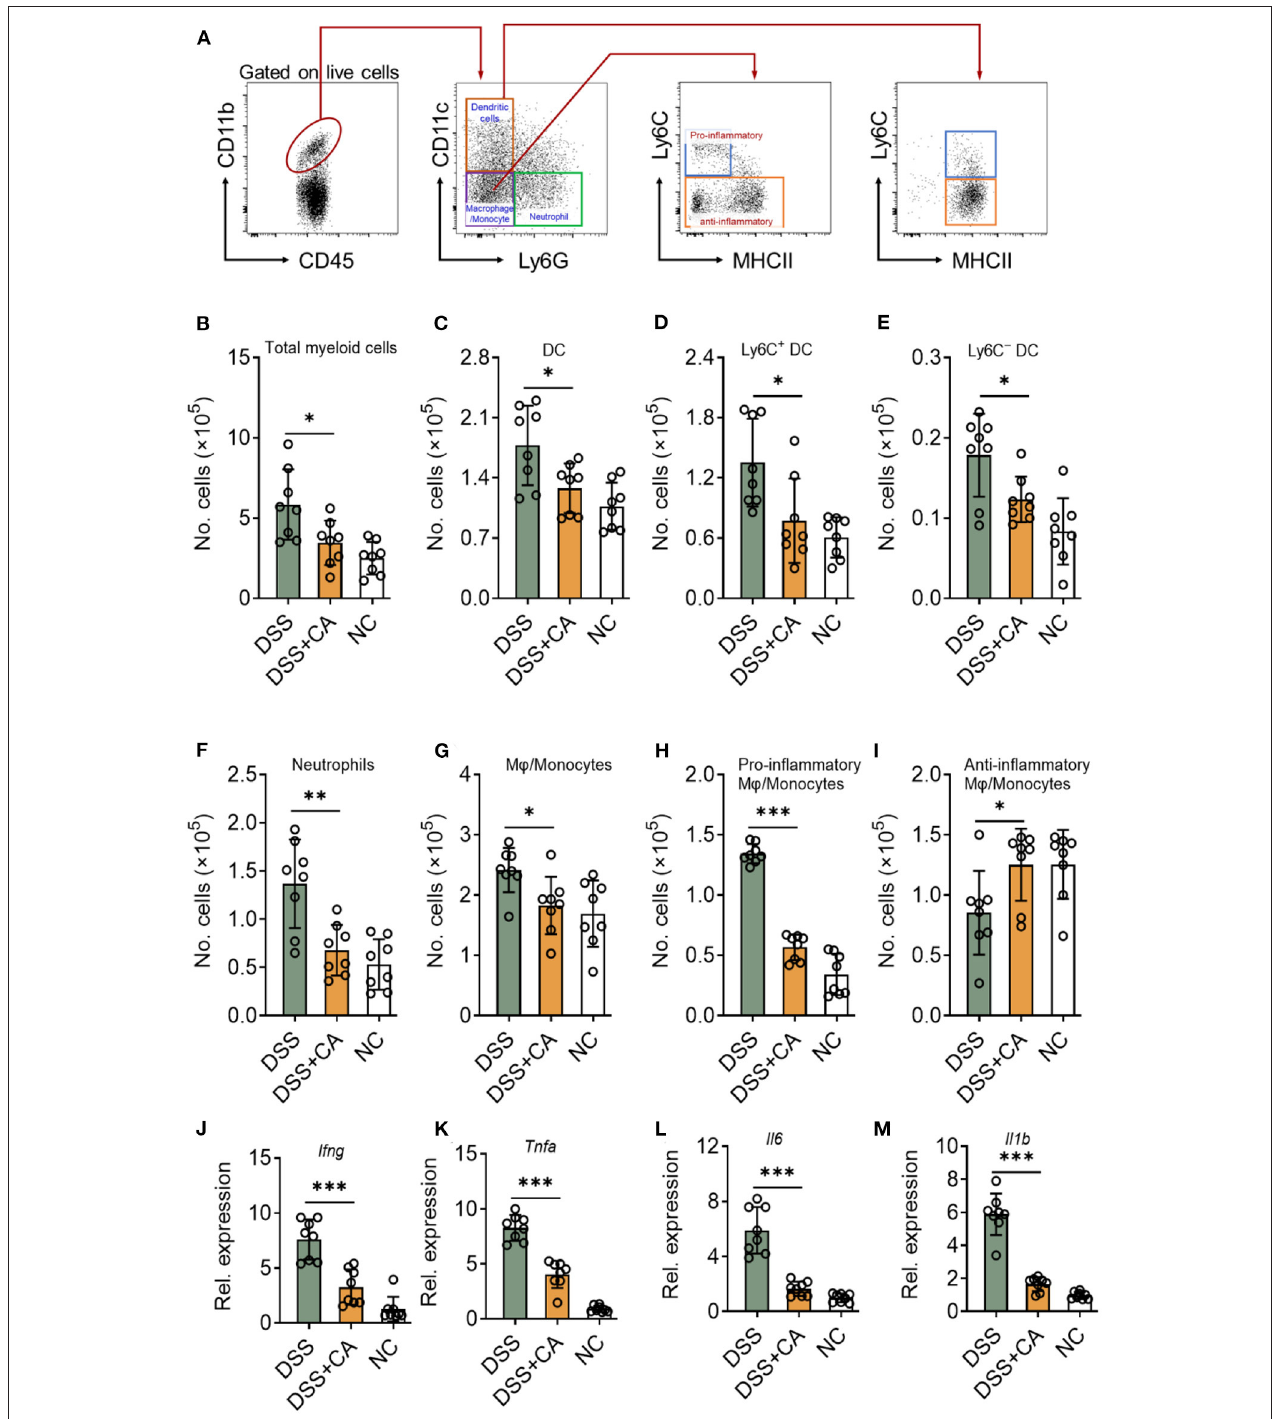
FIGURE 3 | CA suppresses colonic inflammatory responses in DSS-treated mice. Colitis was induced as described in Figure 1 and colon lamina propria leukocyte (LPL) were isolated on day 10. (A) Gating strategy for lamina propria myeloid cells. Different cell populations were identified as follows: total myeloid cells (CD45 + CD11b + ), dendritic cells (DC, CD45 + CD11b + Ly6G − CD11c + ), neutrophils (CD45 + CD11b + Ly6G + ), monocytes/macrophages (CD45 + CD11b + CD11c − Ly6G − ), Ly6C + DC (CD45 + CD11b + Ly6G − CD11c + Ly6C + ), Ly6C − DC (CD45 + CD11b + Ly6G − CD11c + Ly6C − ), total myeloid cells (CD45 + CD11b + ), pro-inflammatory monocytes/macrophages (CD45 + CD11b + CD11c − Ly6G − Ly6C + MHC II − ), and anti-inflammatory monocytes/macrophages (CD45 + CD11b + CD11c − Ly6G − Ly6C − ). Quantification of different cell populations are shown in (B–I) . (J–M) The expression levels of indicated inflammatory agents in colons were determined by qRT-PCR. Dates are presented as mean ± SD. Representative data of three independent experiments are shown. One-way analysis of variance (ANOVA) followed